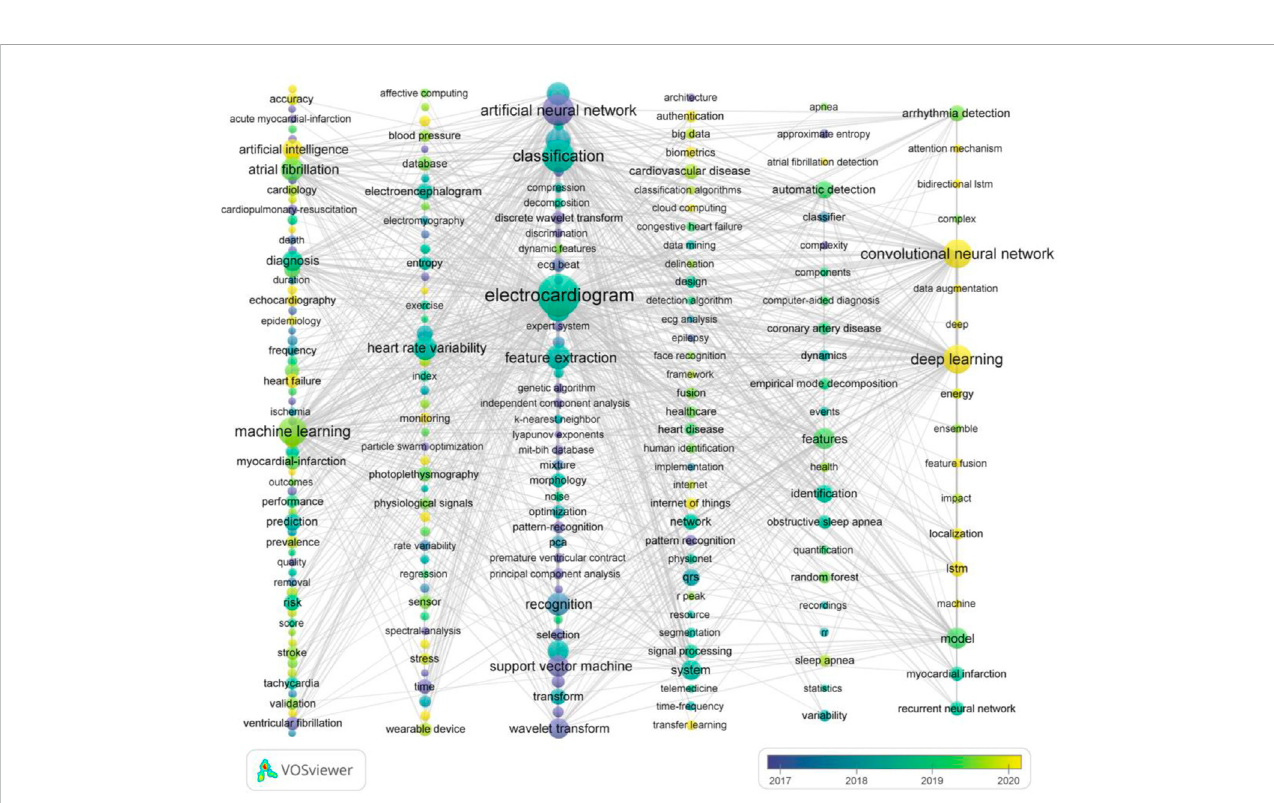
FIGURE 8 The overlay co-occurrence visualization network of 229 keywords with a frequency of more than 10 times for AI in ECG by using VOSviewer. Different colors of nodes represent the average year in which keywords